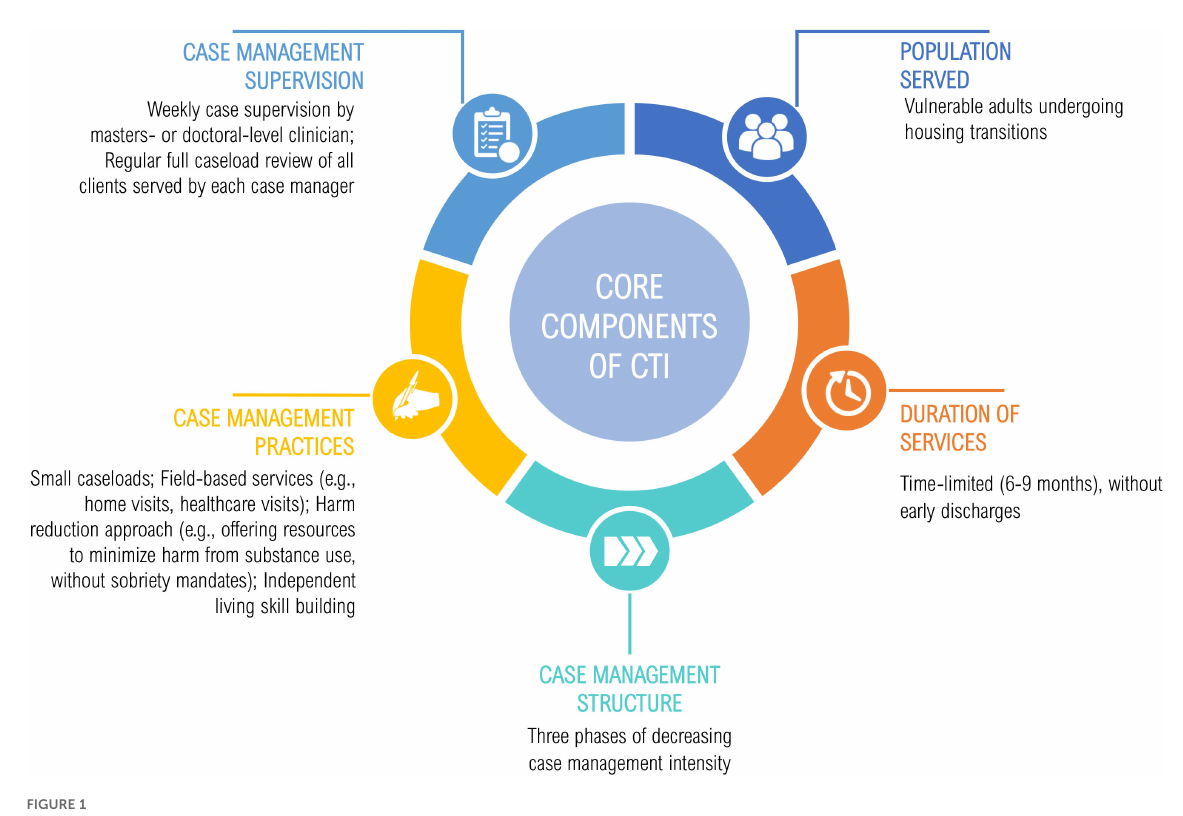
FIGURE1 Core components of critical time intervention